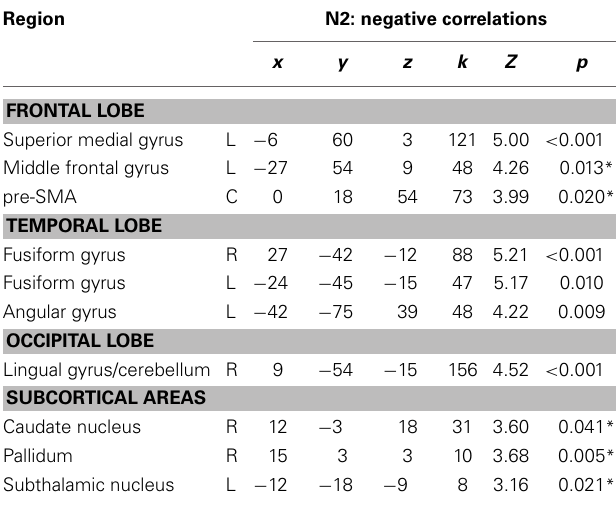
Table 3 | Negative correlations of fMRI BOLD signal with orthogonalized EEG-derived regressor N2 (280–340ms after stimulus onset).